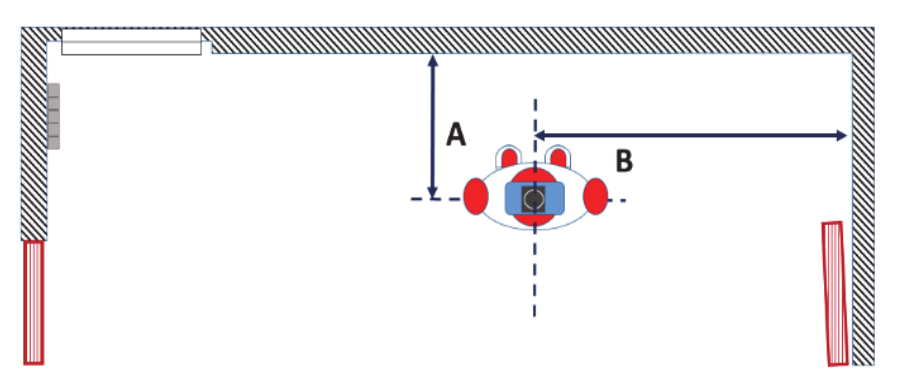
Figure 9. Test #1: map of the room with the robot.